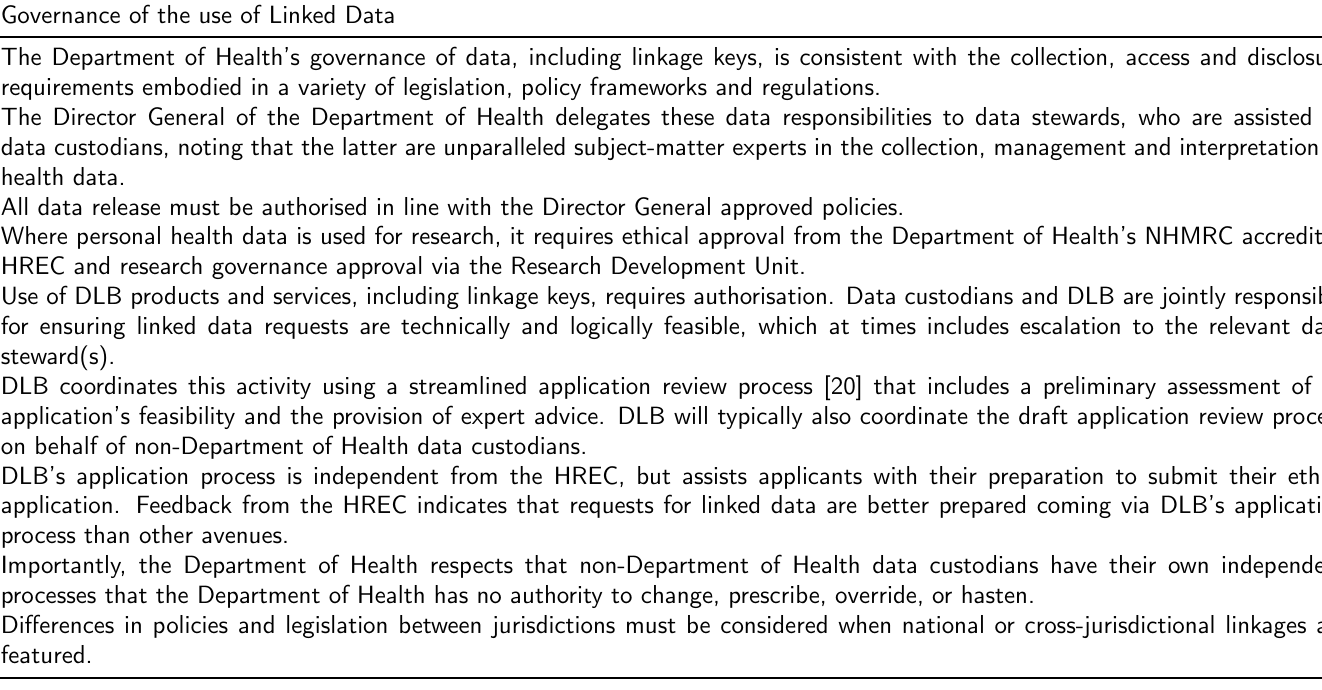
Table 3: Governance of the use of Linked